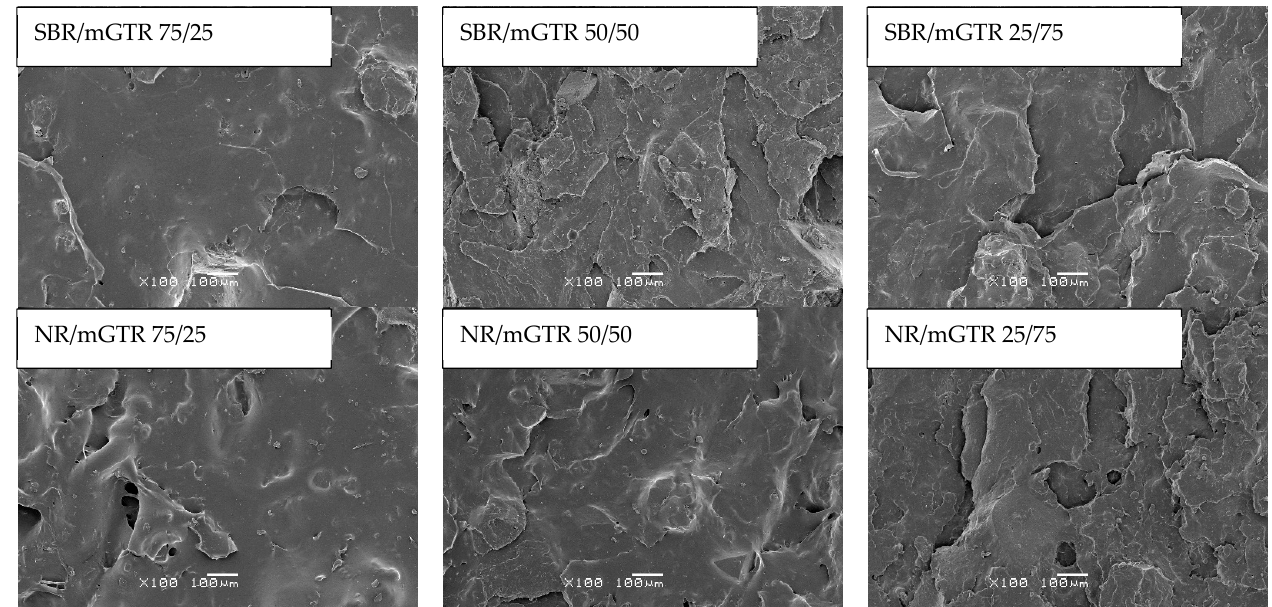
Figure 6. SEM images of rubber/modified GTR blend surface areas after tensile tests (magnification x100).